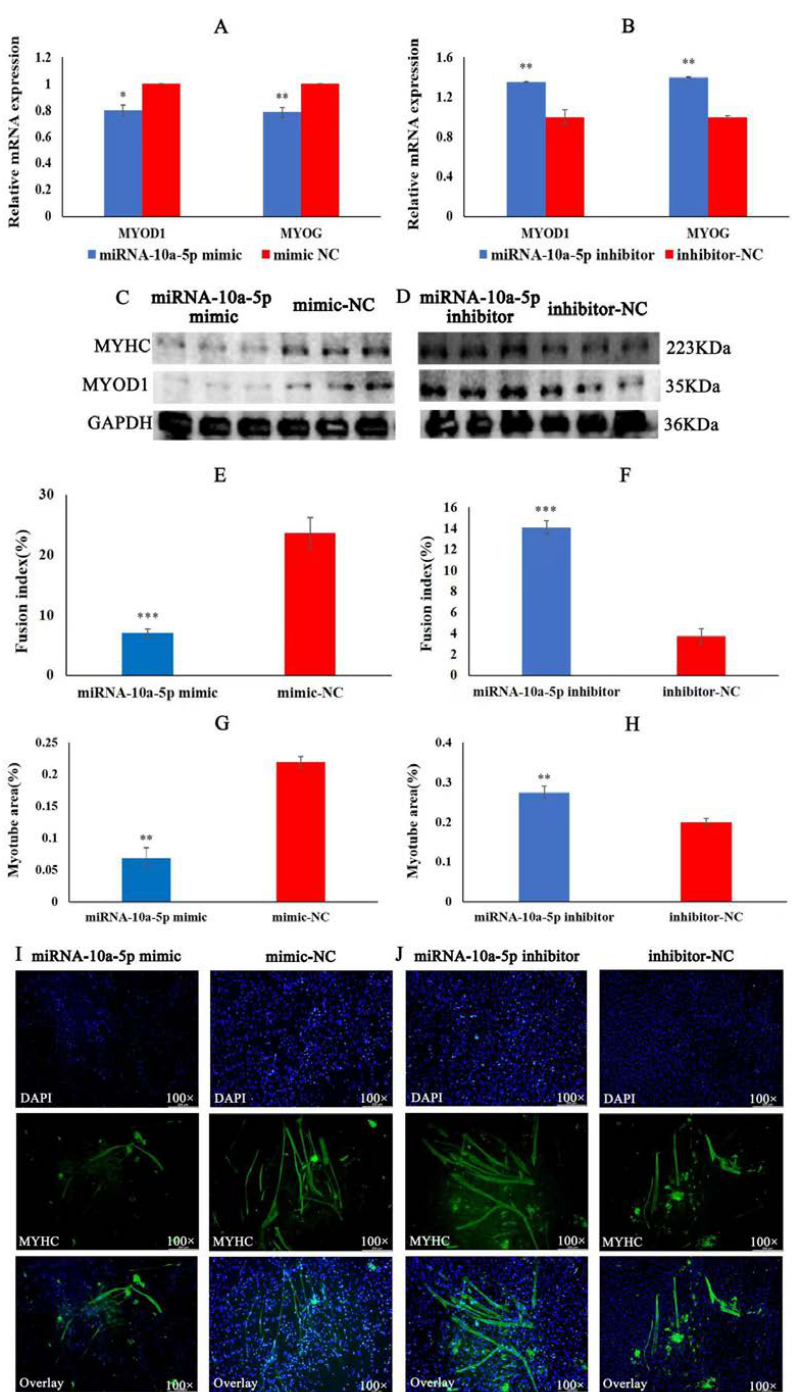
Figure 2. miRNA-10a-5p inhibits chicken myoblasts’ differentiation. ( A , B ) The qRT-PCR results of differentiation marker genes MYOD1 and MYOG after transfection with miRNA-10a-5p mimic and inhibitor. ( C , D ) The protein expression of MYHC and MYOD1 after transfection with miRNA- 10a-5p mimic and inhibitor. ( E , F ) The fusion index (%) of chicken myoblasts after transfection with miRNA-10a-5p mimic and inhibitor. ( G , H ) The statistical results of the myotube area of myoblasts after transfection with miRNA-10a-5p mimic and inhibitor. ( I , J ) The image of IFA under fluorescence inverted microscope after transfection with miRNA-10a-5p mimic and inhibitor. In all graphs, the results are shown as mean ± SEM (standard error of the mean) ( n = 3). * p < 0.05, ** p < 0.01, *** p <